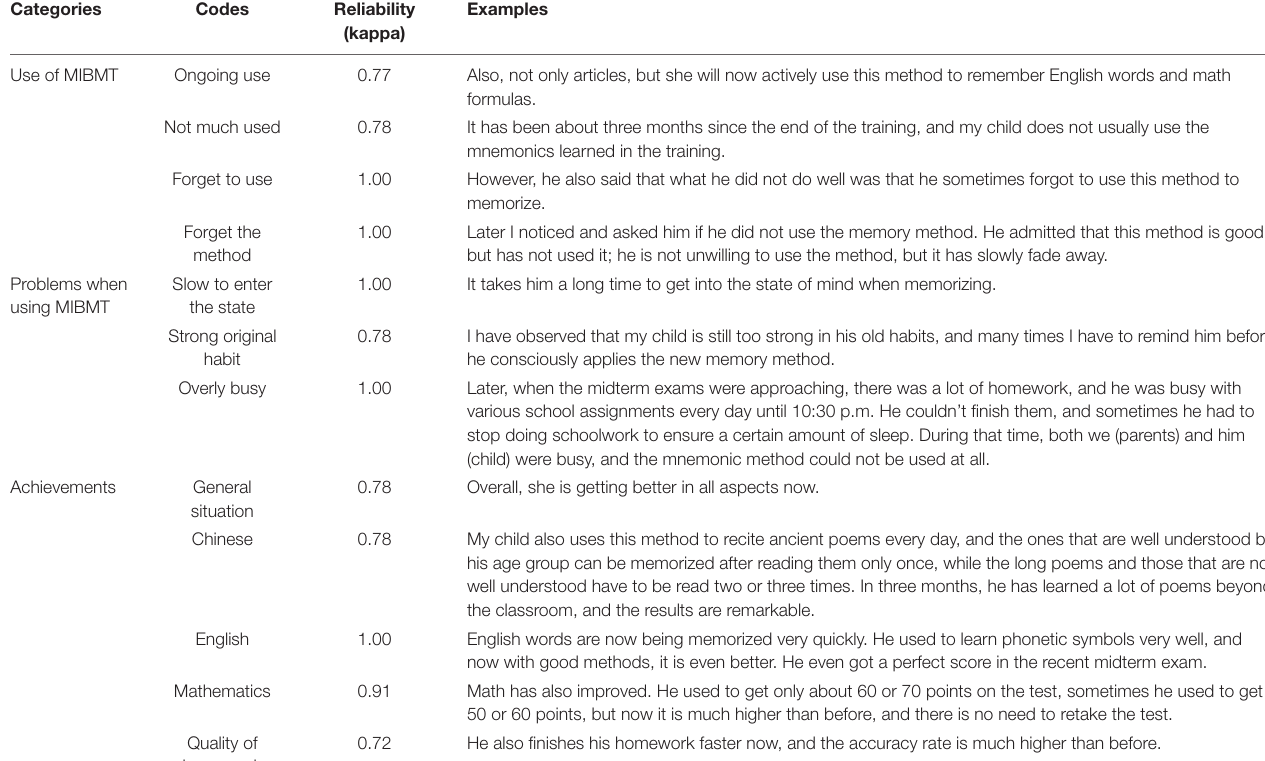
TABLE 15 | Codebook of the content analysis in Experiment